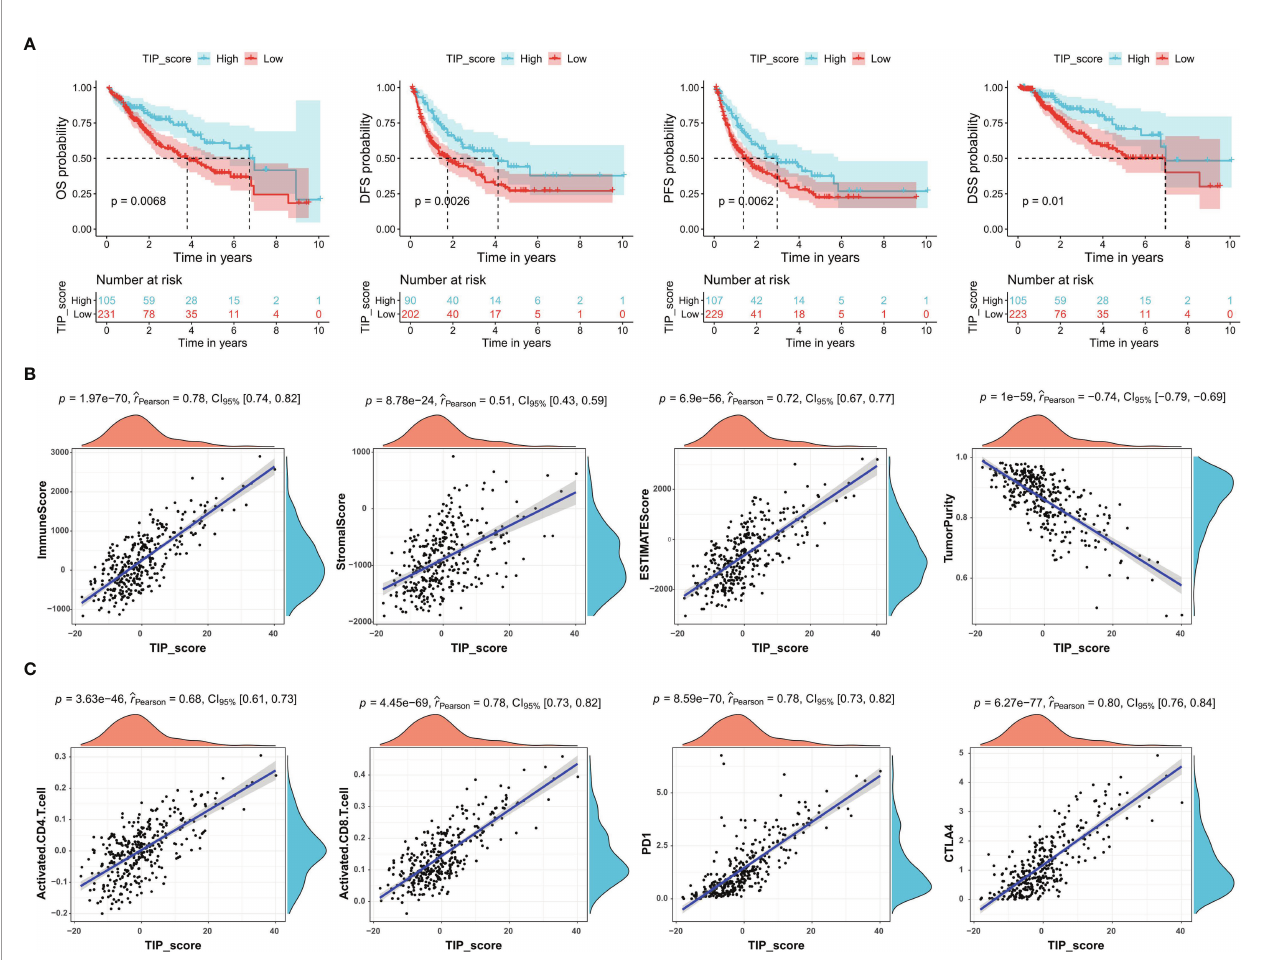
FIGURE 2 | TIP score correlates with the prognosis and the immune state of HCC. (A) Kaplan – Meier survival plots of TIP score for OS, DFS, PFS, and DSS in TCGA-HCC cohort. (B) Correlations between TIP score and immune score, stromal score, estimate score, and tumor purity in HCC. (C) Correlations between TIP score and biomarkers of cancer immunotherapy including activated CD4/CD8 and PD-1/CTLA-4. TIP, tumor immunological phenotype. OS, overall survival; DFS, disease-free survival; PFS, progression-free survival; DSS, disease-speci fi c